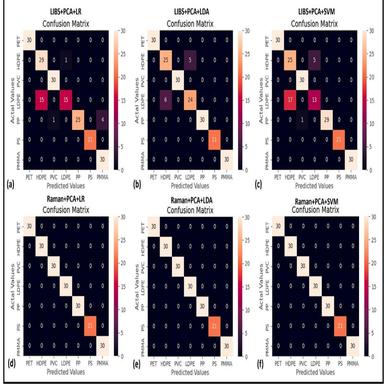
Confusion matrix for different classifiers coupled to PCA decomposition output on LIBS and Raman spectra of plastics.